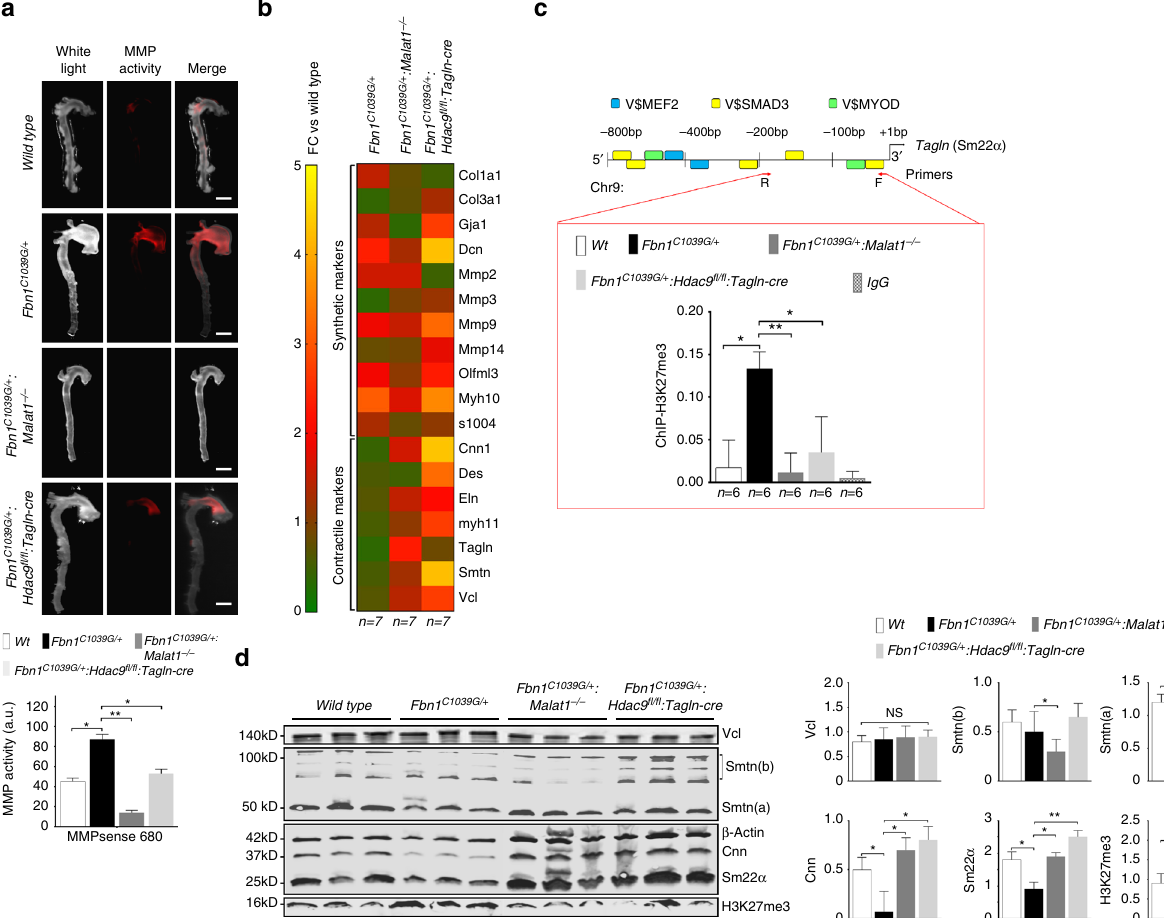
Fig. 7 Genetic disruption of Malat1 or Hdac9 restores in vivo contractile protein expression. a Malat1 or Hdac9 de fi ciency decreases in vivo aortic MMP activity in Fbn1 C1039G/ + mice. Wild-type, Fbn1 C1039G/ + , and Fbn1 C1039G/ + :Malat1 − / − , and Fbn1 C1039G/ + : Hdac9 fl / fl :Tagln-cre mice are injected with MMP sense 680 in vivo prior to sacri fi ce and ex vivo imaging. Bar = 1.5 mm. b Heat map of contractile and synthetic VSMC markers from ascending aortas of six month old Fbn1 C1039G/ + , Fbn1 C1039G/ + :Malat1 − / − , and Fbn1 C1039G/ + : Hdac9 fl / fl :Tagln-cre mice. Levels shown by fold change (FC) vs. wild type. ( n = 7 mice for each genotype). c In vivo chromatin immunoprecipitation (ChIP) assays from mouse aortic tissue ( n = 6 mice for each genotype) using H3K27me3 antibodies at the proximal Tagln (Sm22 α ) promoter. d Malat1 or Hdac9 de fi ciency rescues decreased expression of multiple VSMC contractile proteins in Fbn1 C1039G/ + mice. Western blot of aortas in wild-type, Malat1 − / − , Fbn1 C1039G/ + , Fbn1 C1039G/ + :Malat1 − / − , and Fbn1 C1039G/ + : Hdac9 fl / fl :Tagln-cre mice. Quanti fi cation of protein levels of three replicate experiments is shown. (Student ’ s T -test, NS not signi fi cant, * p < 0.05, ** p < 0.01) Bar graphs are presented as mean with error bars (±SD). Full-length western blots presented in Supplementary Fig.